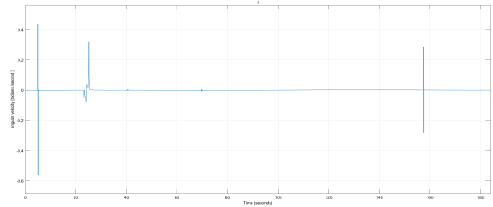
Figure 33. Plot distance P vector without attitude controller